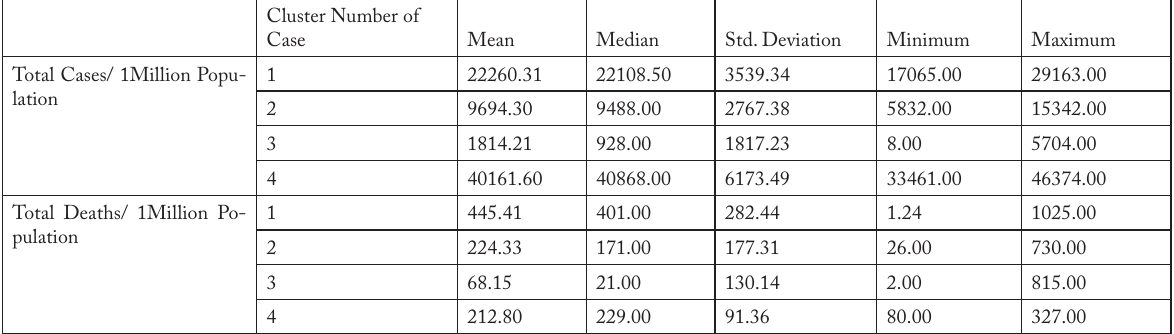
Table 4. Descriptive statistics of clusters according to the k-means clustering.